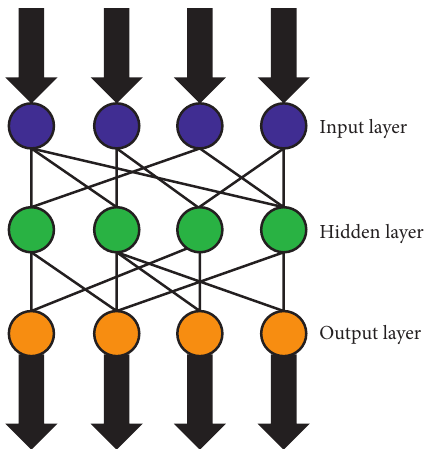
Figure 8: A typical feedforward neural network.